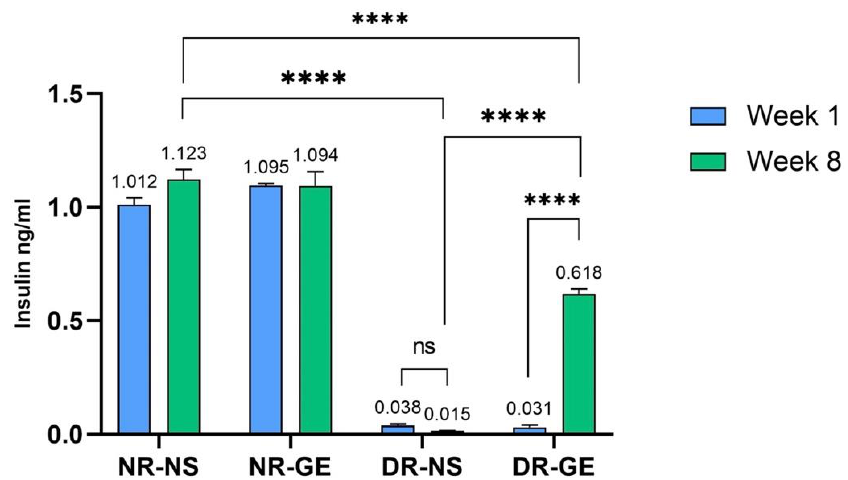
Figure 3. Changes in serum insulin levels (ng/mL) for all rat groups after 1 and 8 weeks of GE treatment. ns: no significance, ****: p ≤ 0.001.